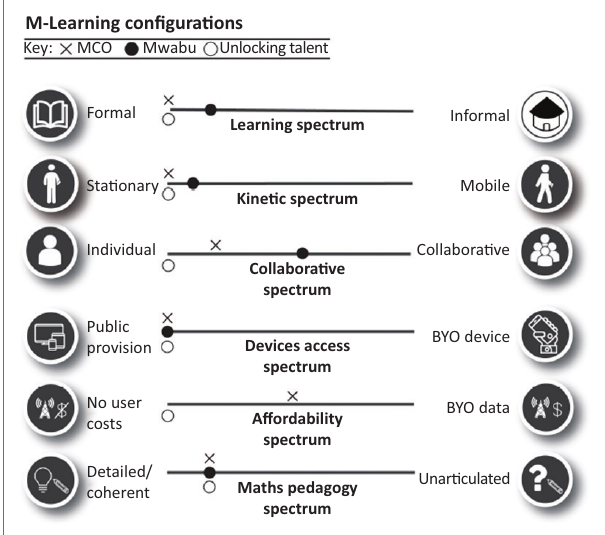
FIGURE 2: Mapping the case study interventions to the m-learning